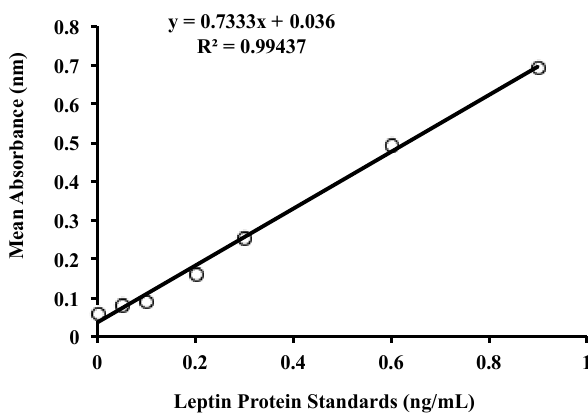
Figure 1. Standard curve for the leptin enzyme-linked immunoassay (ELISA) for whole and skim human milk. Standards were selected according to previous literature investigating levels of leptin in skim human milk, as well as recommendations provided by the leptin kit manufacturer [36].